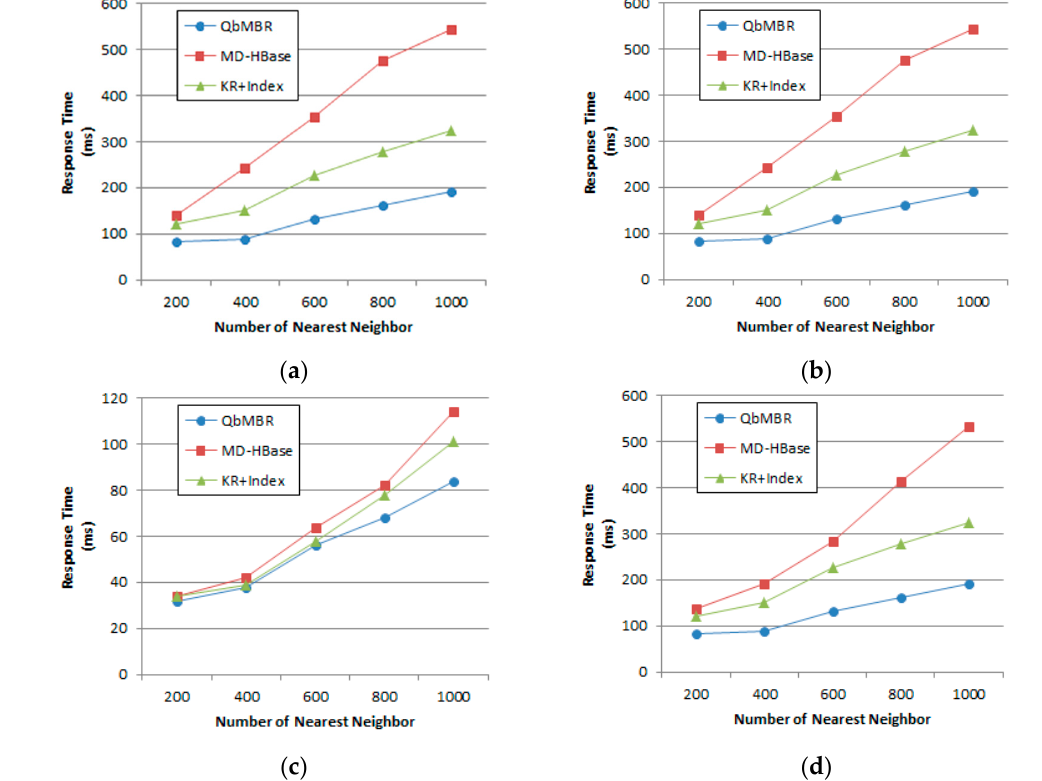
Figure 12. Effect of number of nearest neighbors on response time: ( a ) Synthetic dataset with uniform distribution; ( b ) Synthetic dataset with normal distribution; ( c ) European POI dataset; ( d ) Open street map dataset.